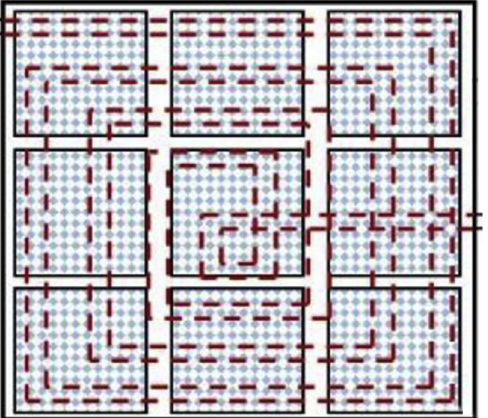
Figure 9. A modified spiral configuration for PVT-assisted hydrogen production. Adapted with permission from Ref. [105]. 2020. Senthilraja et al.